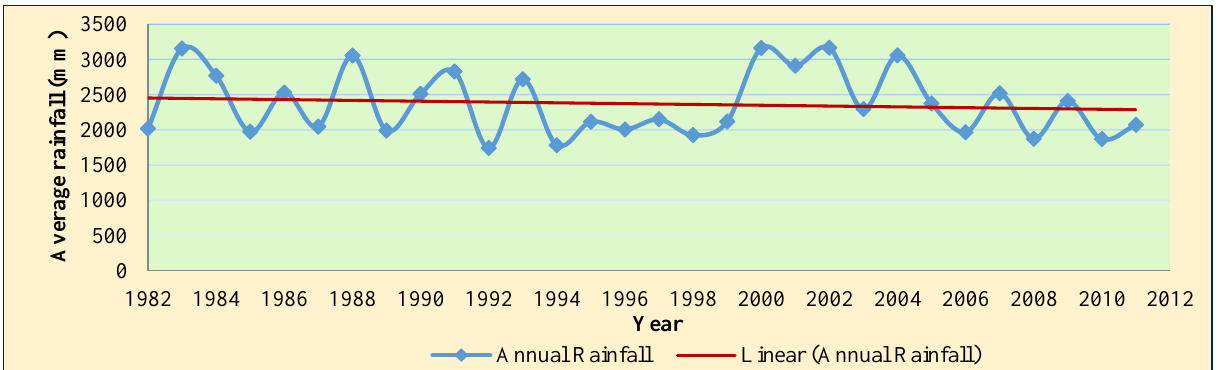
Figure 2. Annual average temperature changing scenario in Lawachara National Park (1980 to 2011).